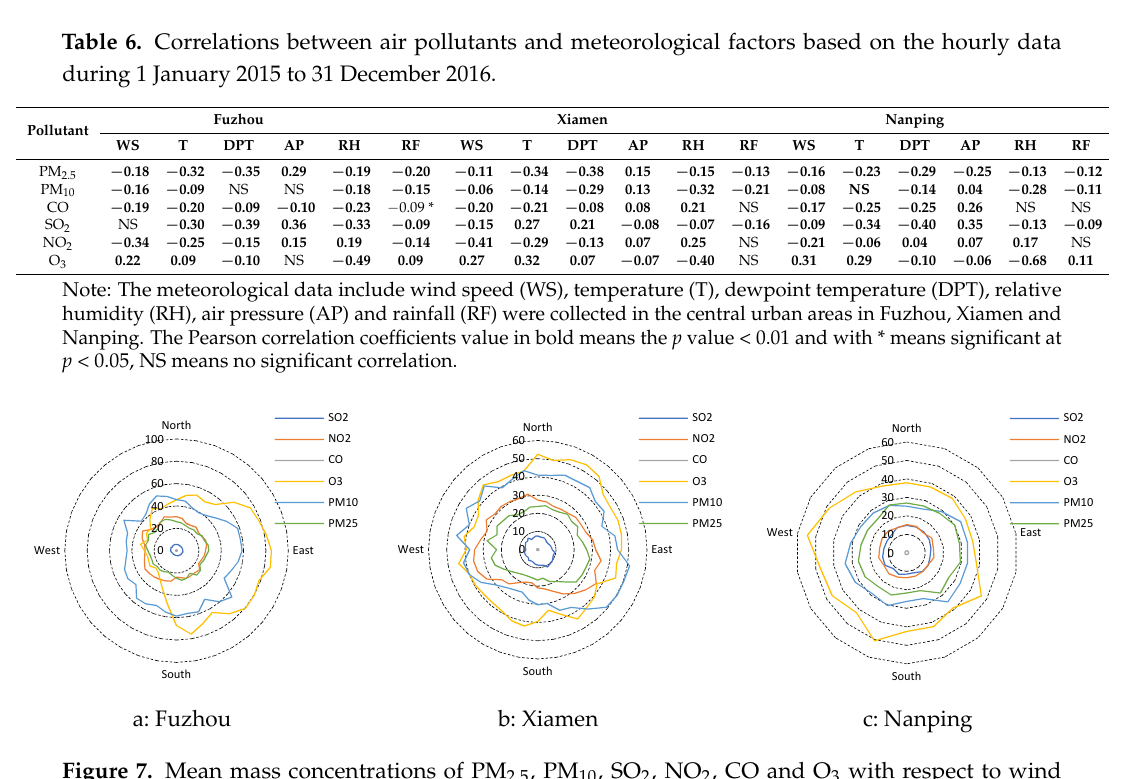
Figure 7. Mean mass concentrations of PM 2.5 , PM 10 , SO 2 , NO 2 , CO and O 3 with respect to wind directions in ( a ) Fuzhou, ( b ) Xiamen and ( c ) Nanping, during Jan 1 st 2015 and Dec. 31 st 2016.